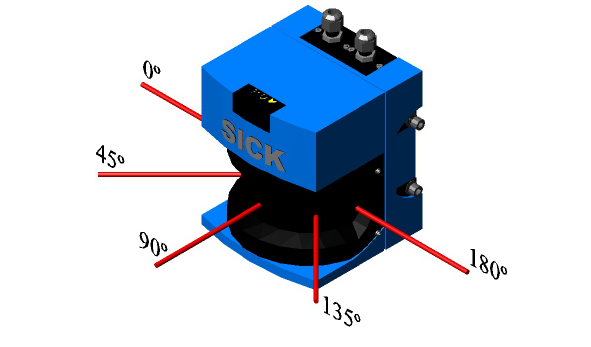
= f (D , D , P Láser 1 en o